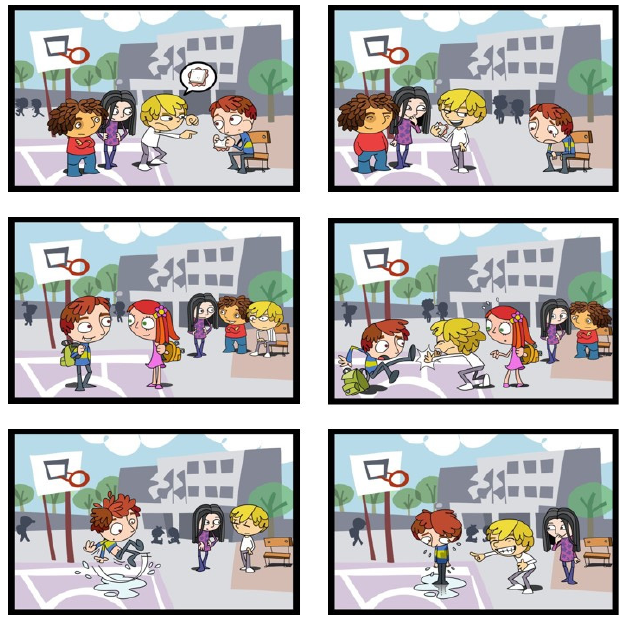
Figure 1. Example of panels from adapted SCAN-bullying based on the original SCAN-bullying by Almeida et al. (2001).